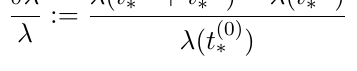
. The colour coding is the same (cid:22)